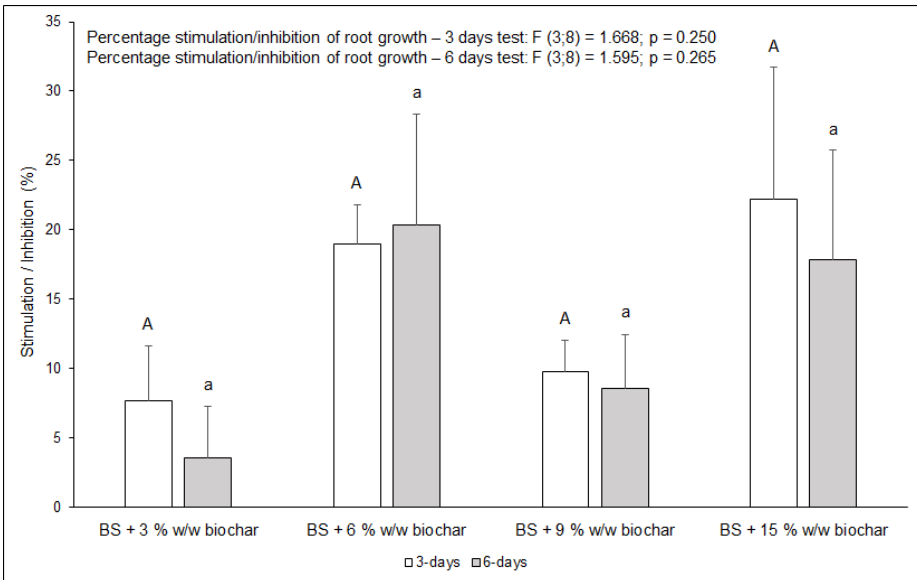
Figure 6. Comparison of inhibition/stimulation of root growth of Sinapis Alba L. after 3 and 6 days of exposure to burnt soil supplemented with biochar in increasing proportions (applied to burnt soil). Average values (n = 3) + SE are presented, different uppercase letters indicate significant differences between individual variants after 3 days of testing and small letters after 6 days (one-way ANOVA with post hoc Tukey’s HSD test). The results of the F test are shown at the top of the